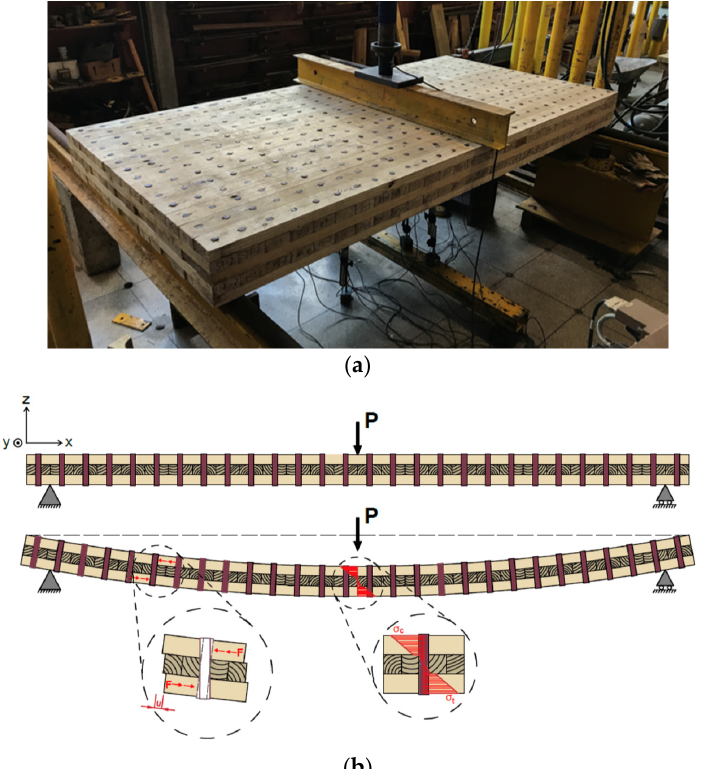
Figure 9. Three-point bending tests of a DCLT: ( a ) longitudinal bending test, and ( b ) interlayer in-plane slip movement, shear and bending forces in the panel [92].